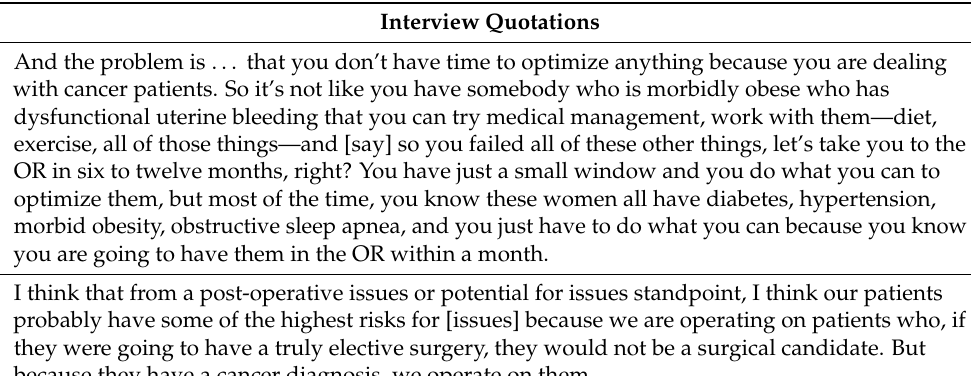
Table 3. Surgical candidacy and medical comorbidities in oncology patients.